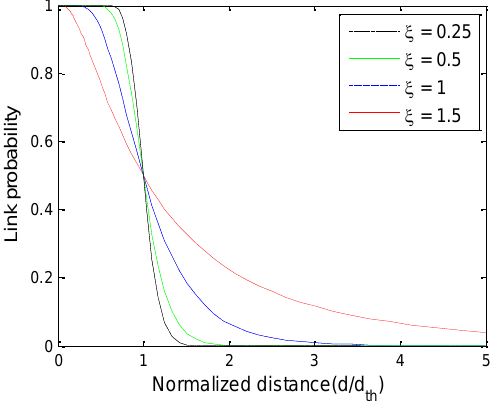
Figure 2. Model of link connection success rate.